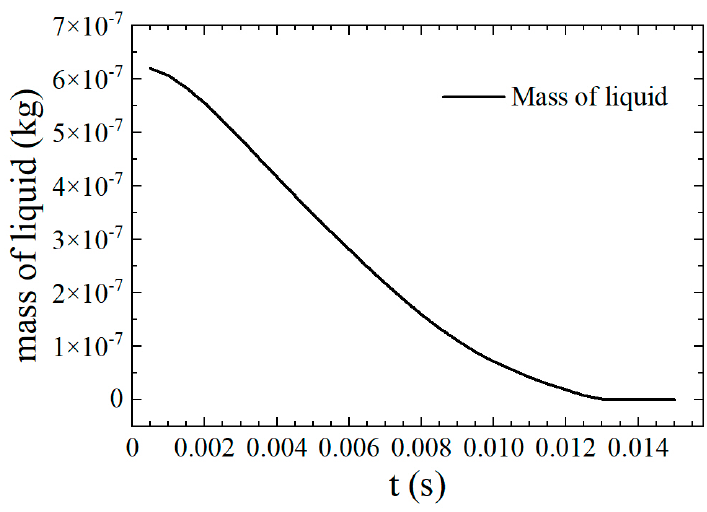
Figure 4. Drying curve of water-based ink.